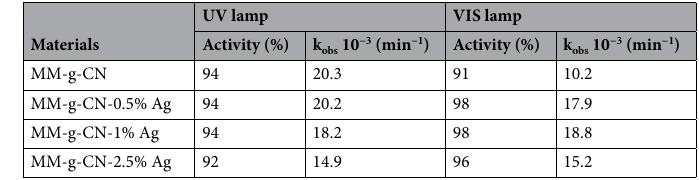
Table 10. Activity and kinetic constant of pristine and Ag NPs modified MM-g-CN (UV vs. VIS lamp irradiation).